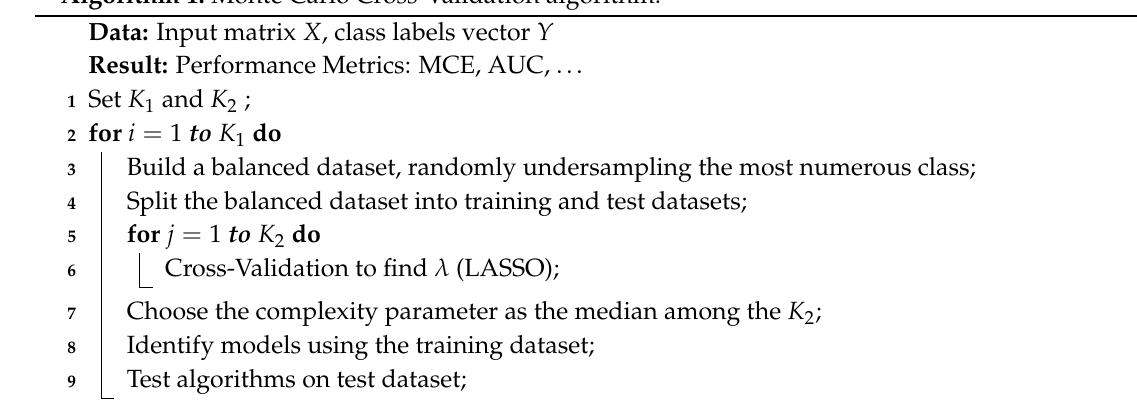
Algorithm 1: Monte Carlo Cross-Validation